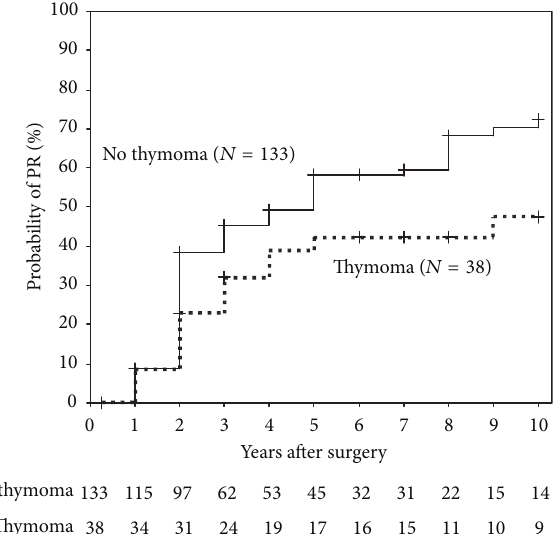
Figure 5: The modified PR is shown in thymoma patients (broken line) compared with nonthymoma patients (solid line). Vertical bars indicate censured data. A significant difference was found between the two curves (log-rank test, 𝑃 = 0.04